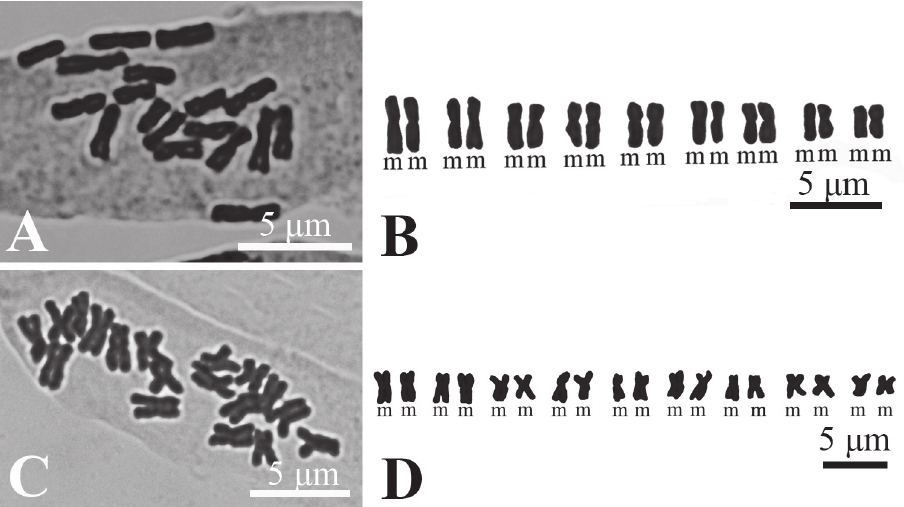
Figure 4. Micrographs of somatic metaphase chromosomes ( A, C ) and the karyotype ( B, D ) of Aster quanzhouensis from two different populations. ( A, B Dehua county, Quanzhou, Fujian, China; C, D Yongchun county, Quanzhou, Fujian,